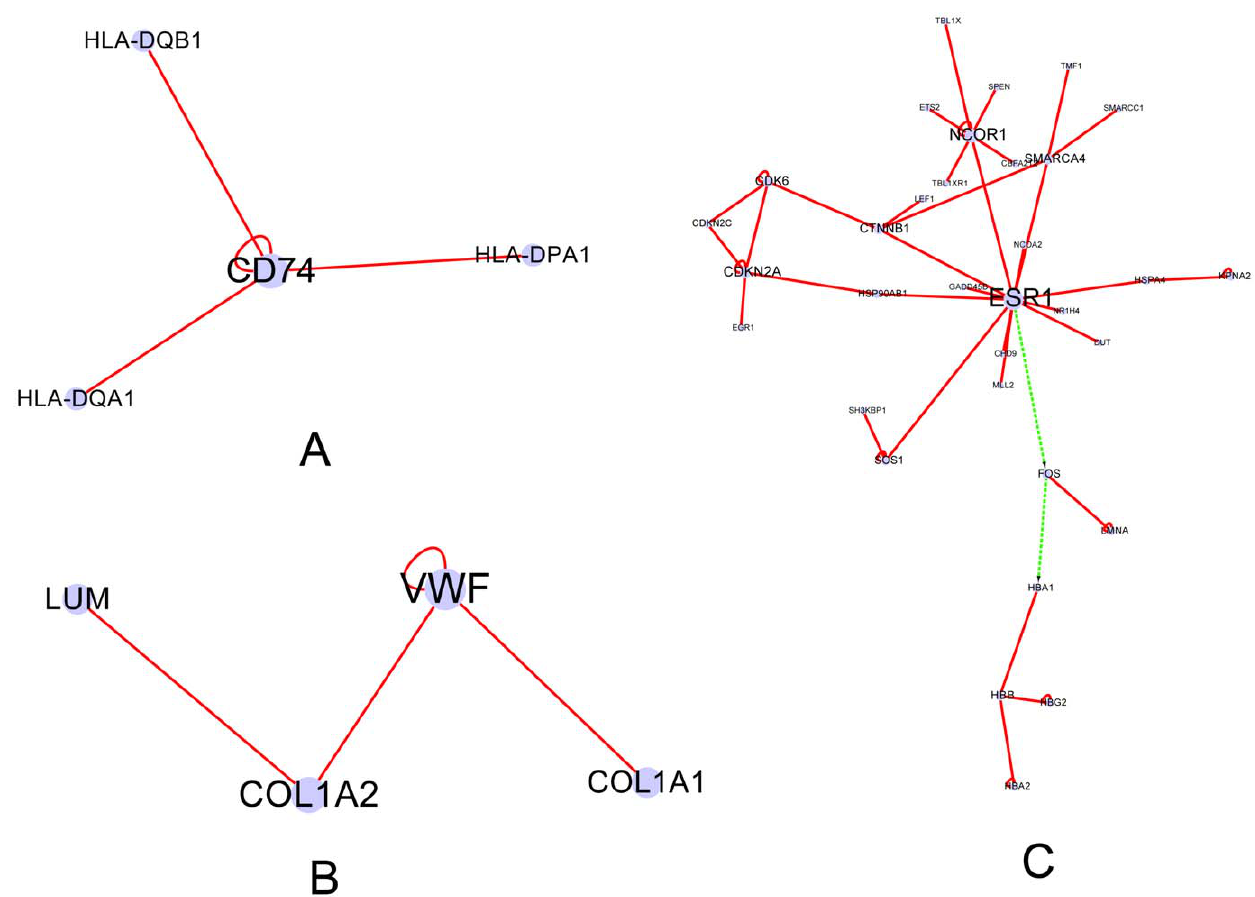
Figure 3. Sub networks that mentioned in discussion. (A) Sub network that deregulated initially from hepatitis C. (B) One of the sub networks that deregulated initially from cirrhosis; (C) One of the sub networks that deregulated initially from BCLC stage 0 HCC.